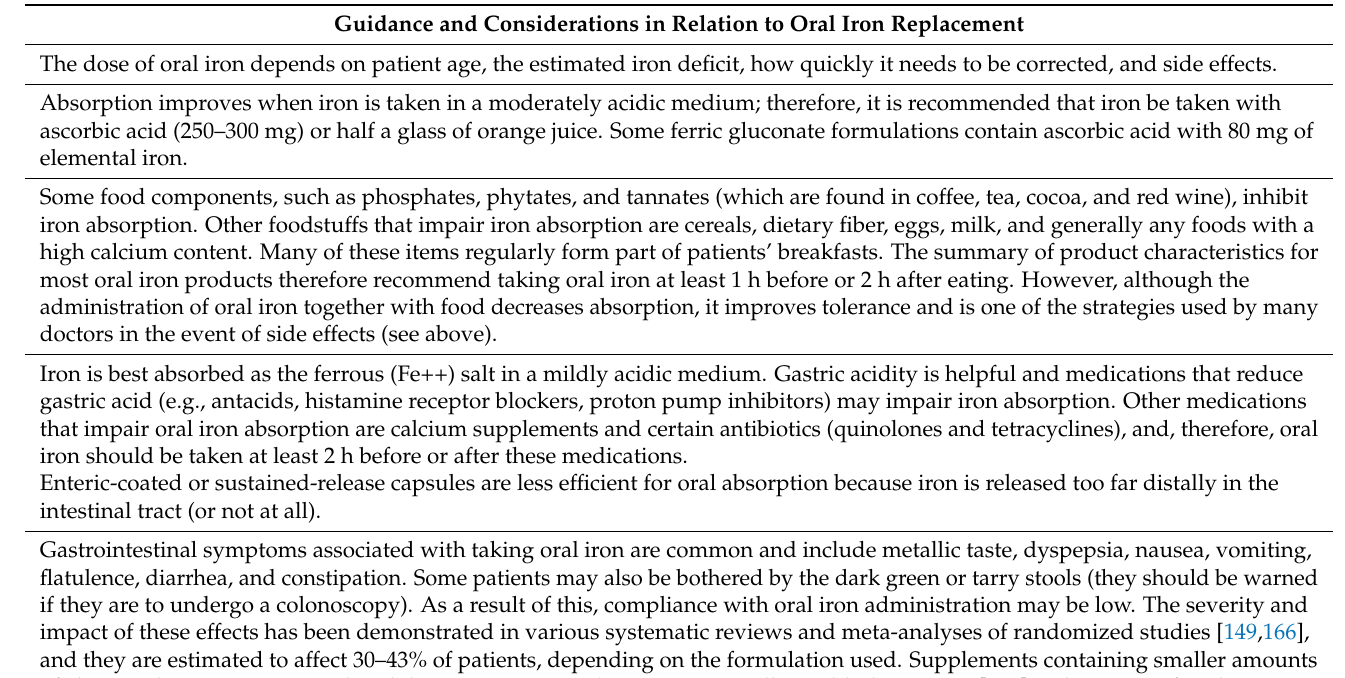
Table 3. Guidance and considerations in relation to oral iron